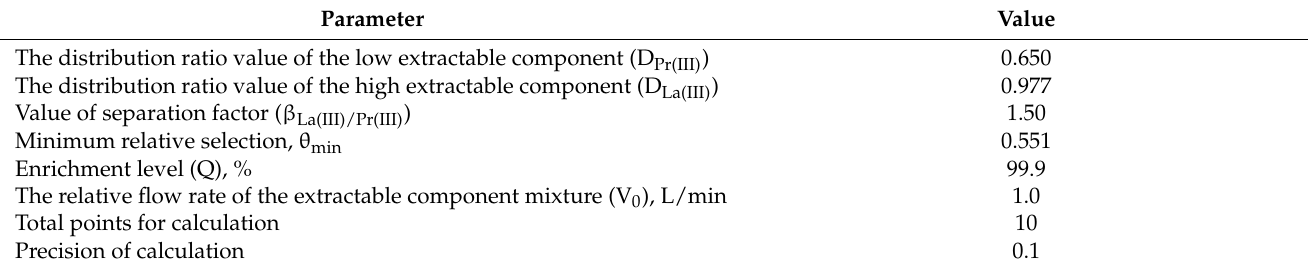
Table 5. Input data for calculation of multistage counter-current solvent extraction separation of La(III) and Pr(III) using «KASKAD» original PC software.